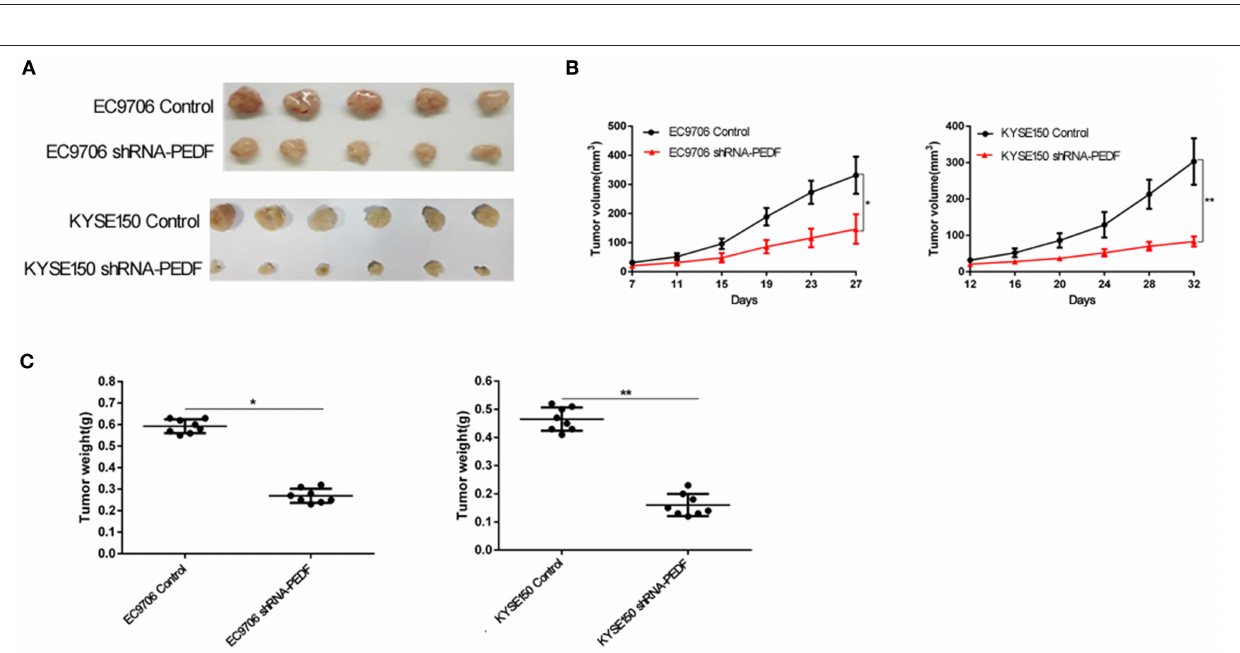
FIGURE 3 | Effect of PEDF knockdown on cell cycle and apoptosis of esophageal cancer cells. (A) Cell cycle change of esophageal cancer cells after knocking down PEDF. (B) Apoptosis assay of esophageal cancer cells after knocking down PEDF. (C) Western blot analysis of apoptosis-related proteins after knocking down PEDF in esophageal cancer cells. * < 0.05, ** < 0.01.